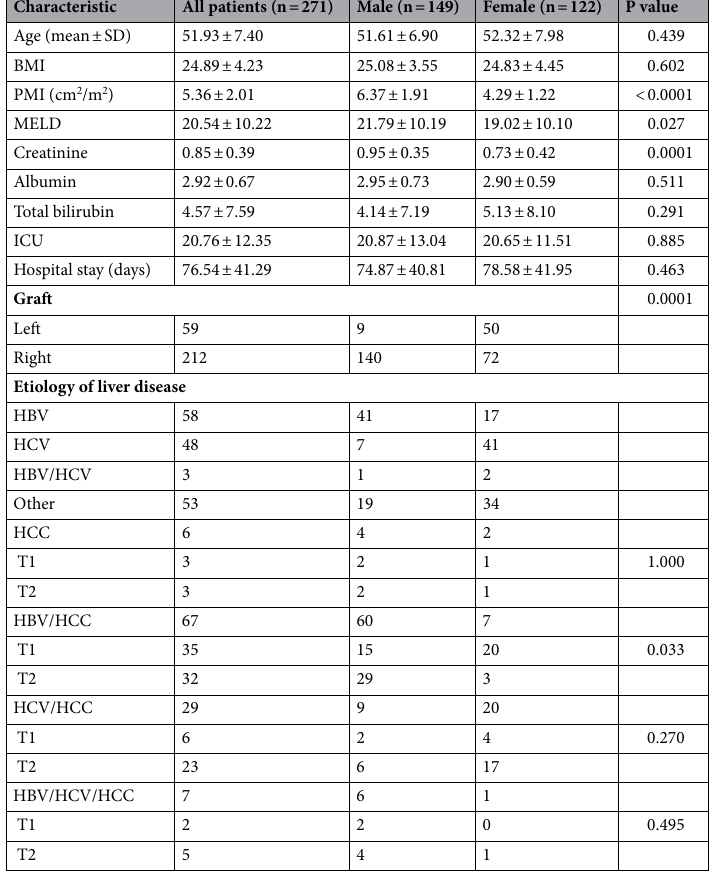
Table 1. Demographic and clinical characteristics of LDLT recipients. BMI, Body mass index; MELD, Model for end-stage liver disease; ICU, Intensive care unit; HBV, Hepatitis B virus; HCV, Hepatitis B virus; HCC, Hepatocellular carcinoa.